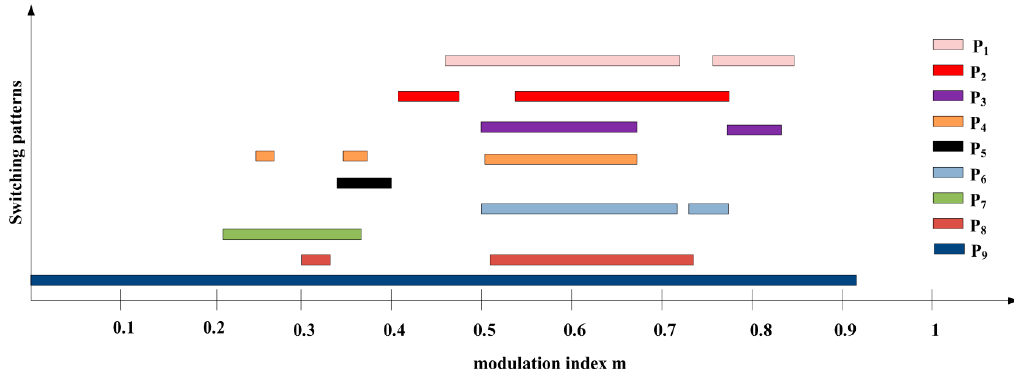
Figure 7. Switching angle as a function of m for all the patterns.